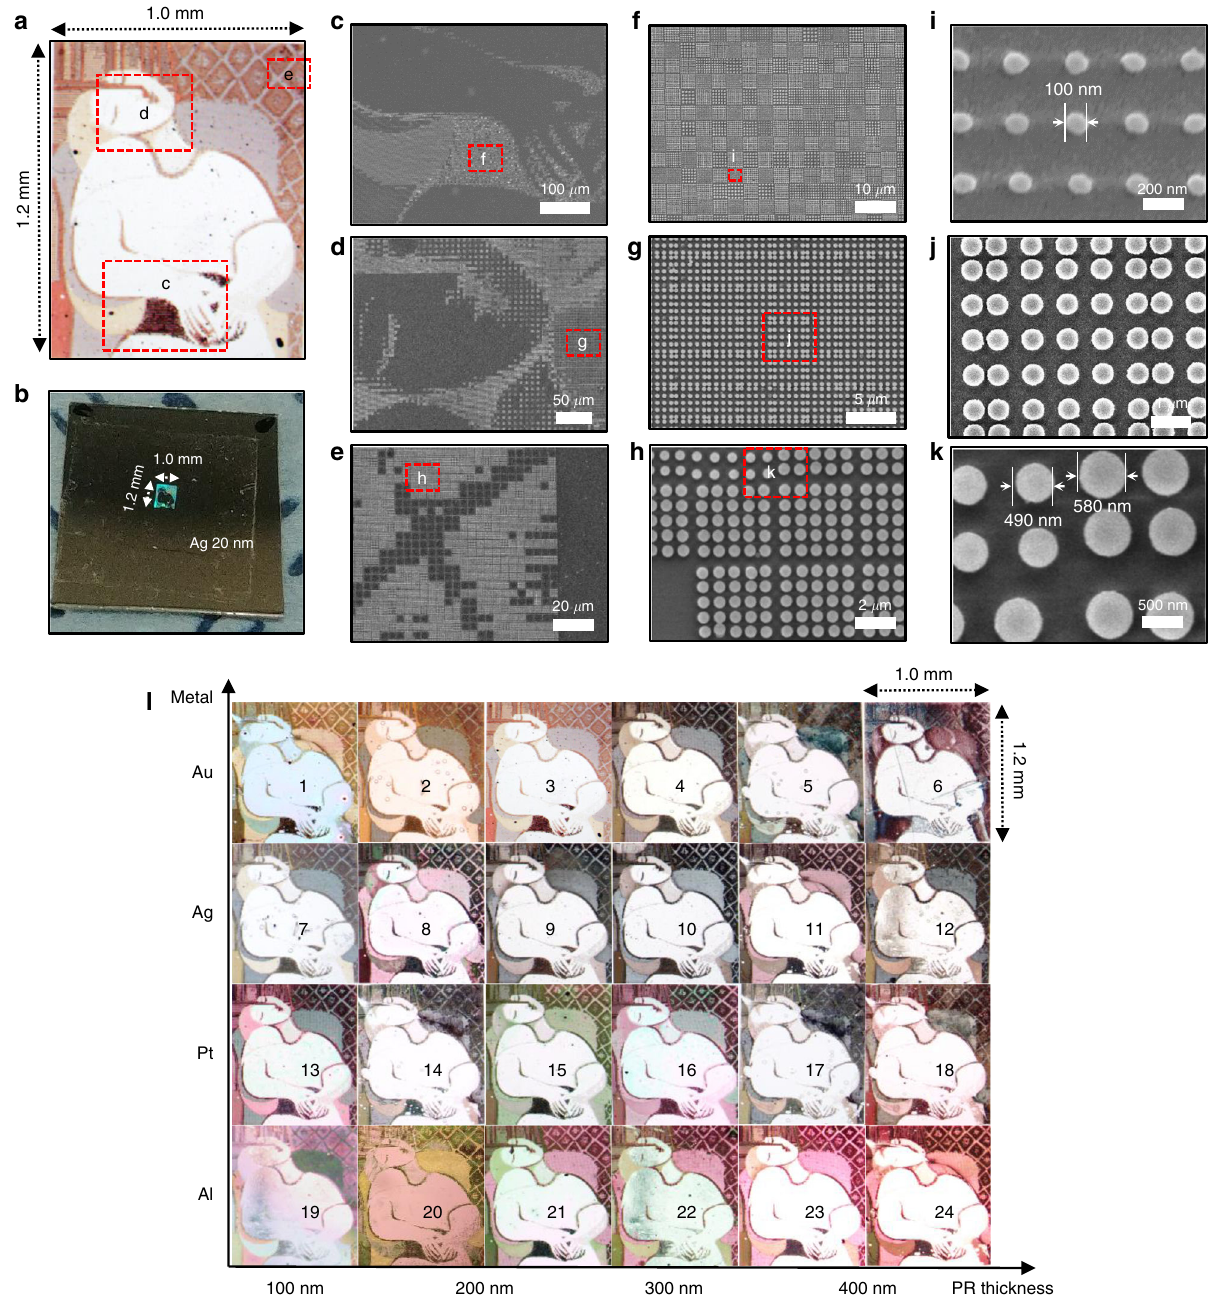
Fig. 7 Soft photomask allows for full-color and large-scale printing. a , b Optical microscope image ( a ) and photograph by mobile phone ( b ) of a photo- realistic Picasso painting produced using plasmonic nanodisks. c – k SEM images of three different parts of the plasmonic structures indicated in ( a ) at three magni fi cations, from low (left panels) to high (right panels). Scale bars: 100 μ m for ( c ), 50 μ m for ( d ), 20 μ m for ( e ), 10 μ m for ( f ), 5 μ m for ( g ), 2 μ m for ( h ), 200 nm for ( i ), 1 μ m for ( j ), 500 nm for ( k ). l Millimeter-scale printing with various colors by a consecutive optical lithography process. The different colors were obtained by changing the thickness of the photoresist in increments of 100 nm and varying the deposited metal species (Au, Pt, Ag, and Al). The original image was converted to plasmonic structures using encoding algorithms. Process and design parameters of each plasmonic image are summarized in Supplementary Table